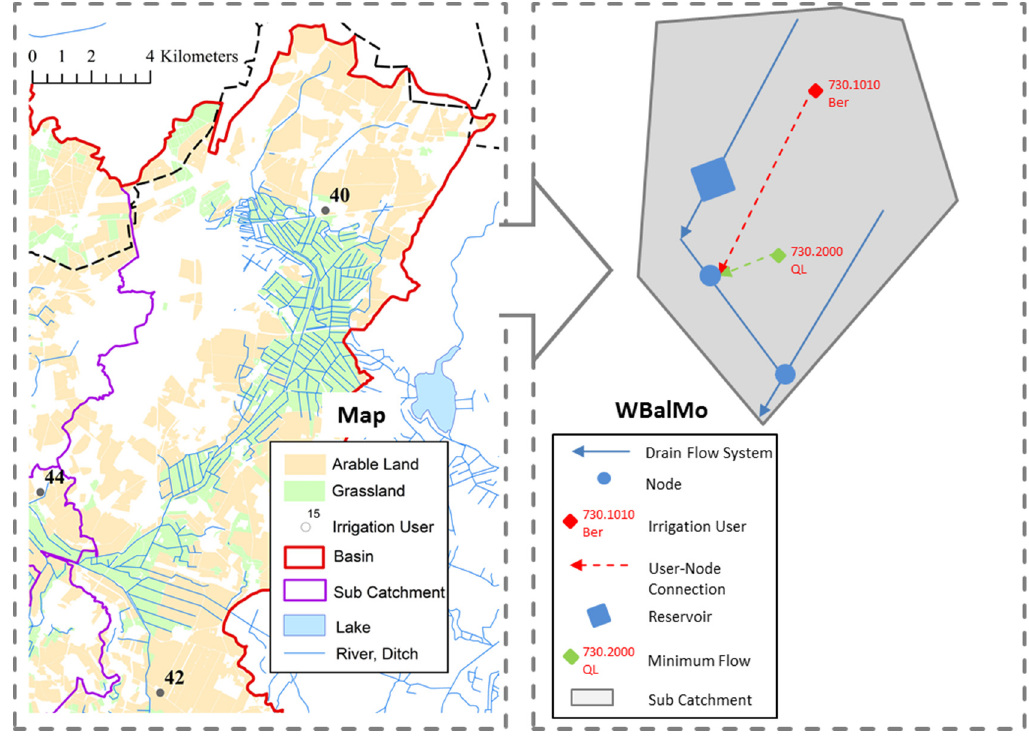
Figure 1. Scheme of the transmission of the drain flow system, water users and other information relevant for water management into the WBalMo model